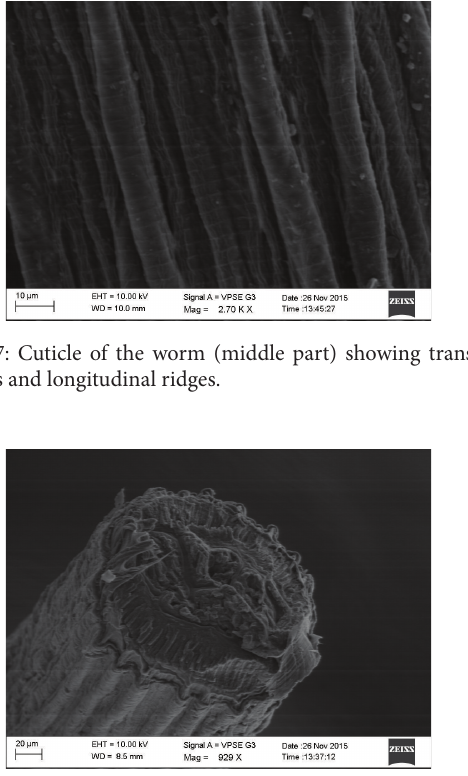
Figure 6: Posterior end of the worm showing thick longitudinal ridges.